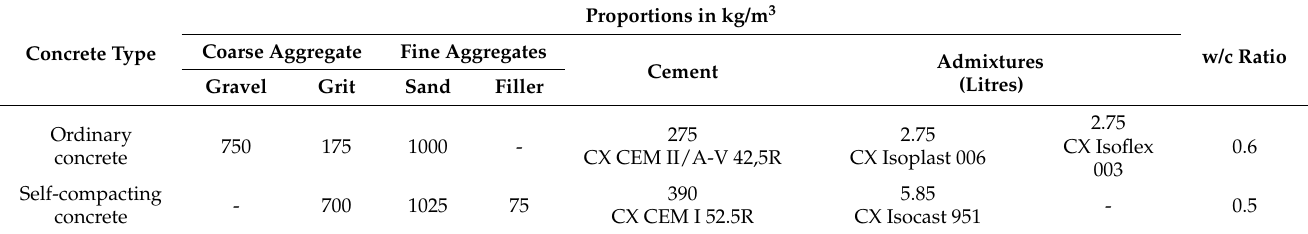
Table 6. Mix proportions for second-stage